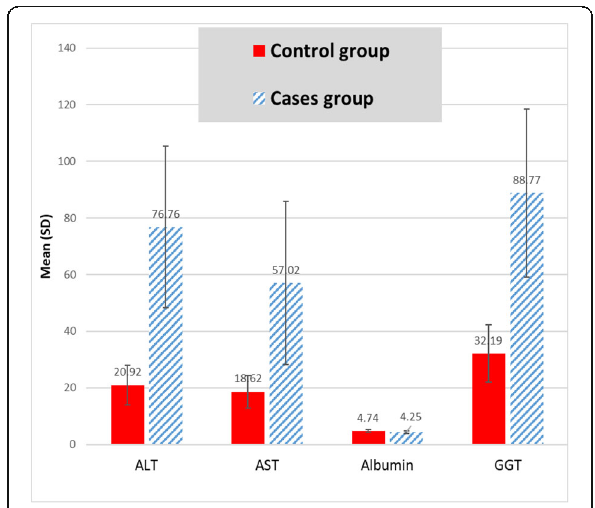
Fig. 1 Significant differences in the liver function tests between the studied